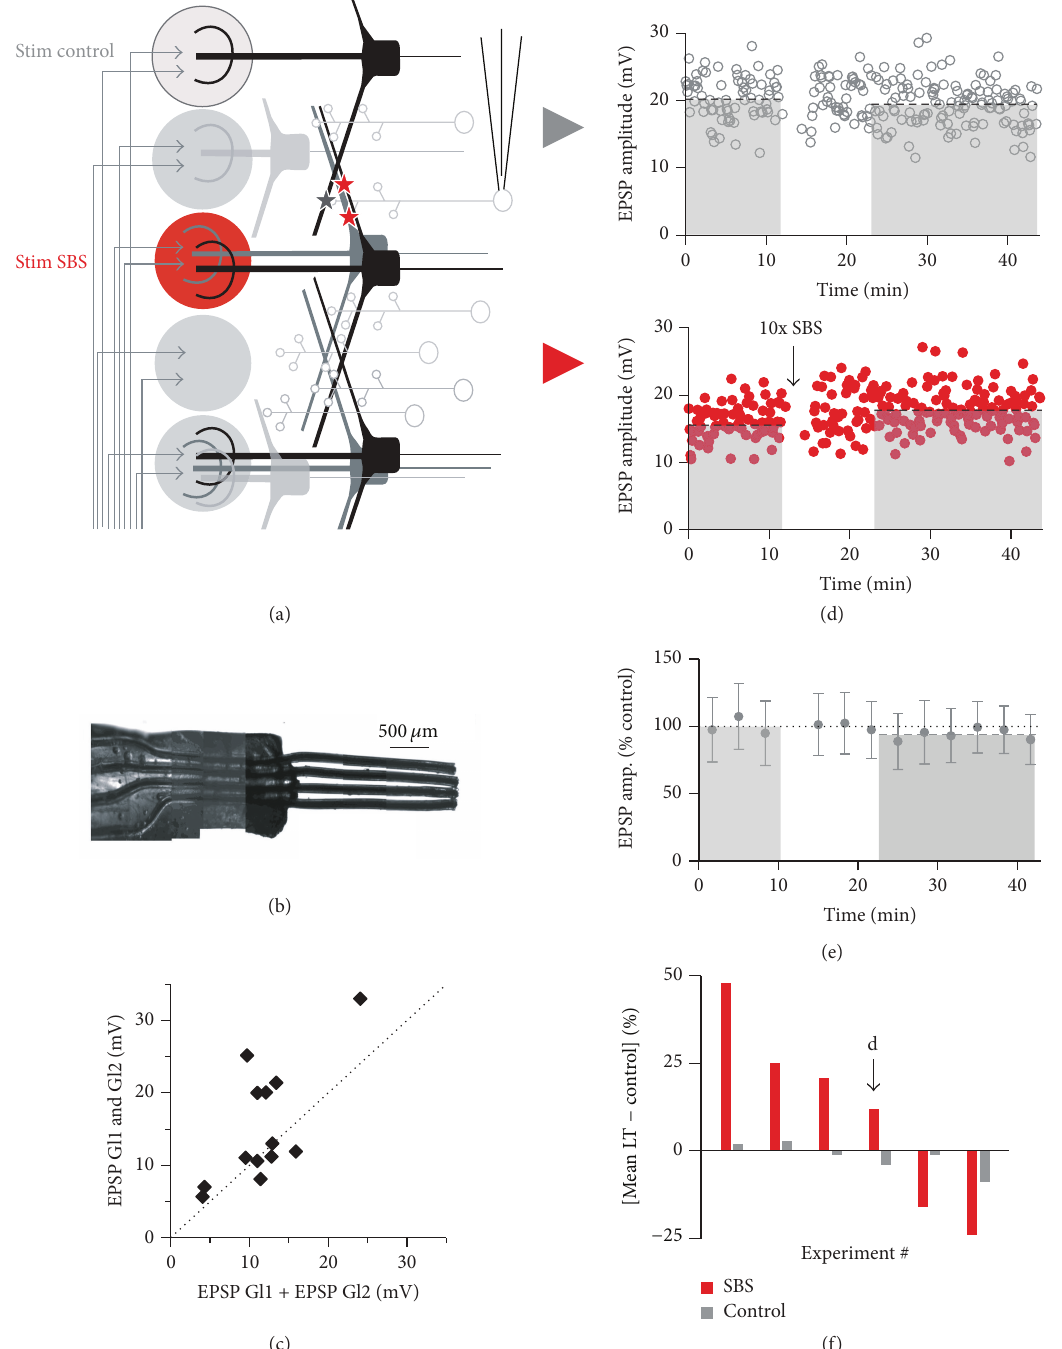
Figure 5: SBS results in homoglomerular plasticity. (a) Scheme of experimental configuration for intermittent stimulation of glomeruli. Two stimulated glomeruli were separated by at least one nonstimulated glomerulus. (b) Photograph of custom-built stimulation electrode (see Section 2). The wires appear wider than their actual size of 75 𝜇 m due to their Teflon coating. (c) Test for independence of sets of synapses ( 𝑛 = 14 experiments). Scatterplot of EPSP amplitudes of combined activation of two neighboring electrodes versus added EPSP amplitudes in response to individual stimulation of these glomeruli. (d) Individual experiment with intermittent stimulation. Top: control glomerular pathway without induction. Control mean 20.2 mV; long-term mean 19.3 mV (dashed black lines). Bottom: glomerular pathway with SBS induction. Control mean 15.8 mV; long-term mean 17.7mV (dashed black lines). (e) Cumulative data from control glomerular pathway normalized to baseline ( 𝑛 = 6 , long-term mean 98 ± 5 % of control, dashed grey line). (f) Cumulative display of experiments. Red bars: long-term change (LT mean − control mean) in SBSed glomerular pathway; grey bars: long-term change in control glomerular pathway. The black arrow indicates the experiment shown in